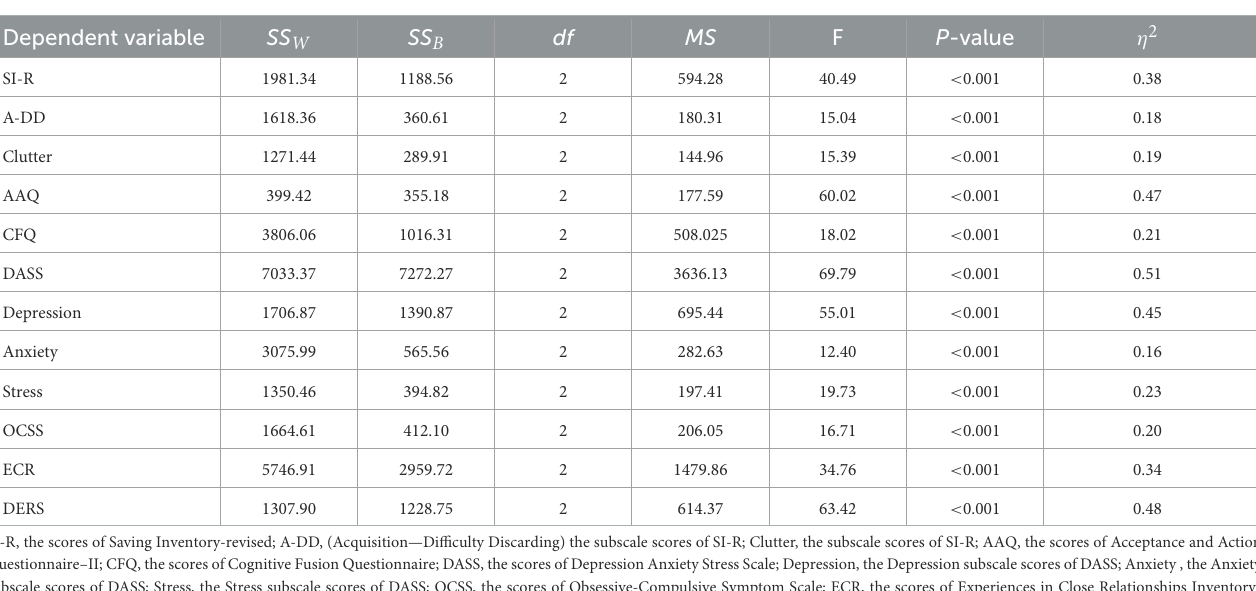
TABLE 4 The results of one-way ANCOVA.